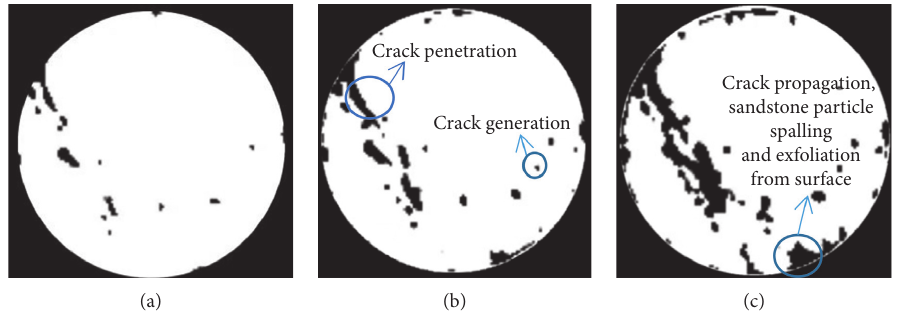
Figure 10: Degradation of the mesostructure of fine sandstone